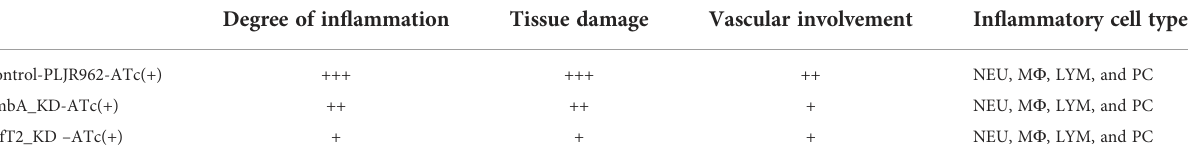
TABLE 1 Histopathology evaluation of infected mice ’ tails. Degree of in fl